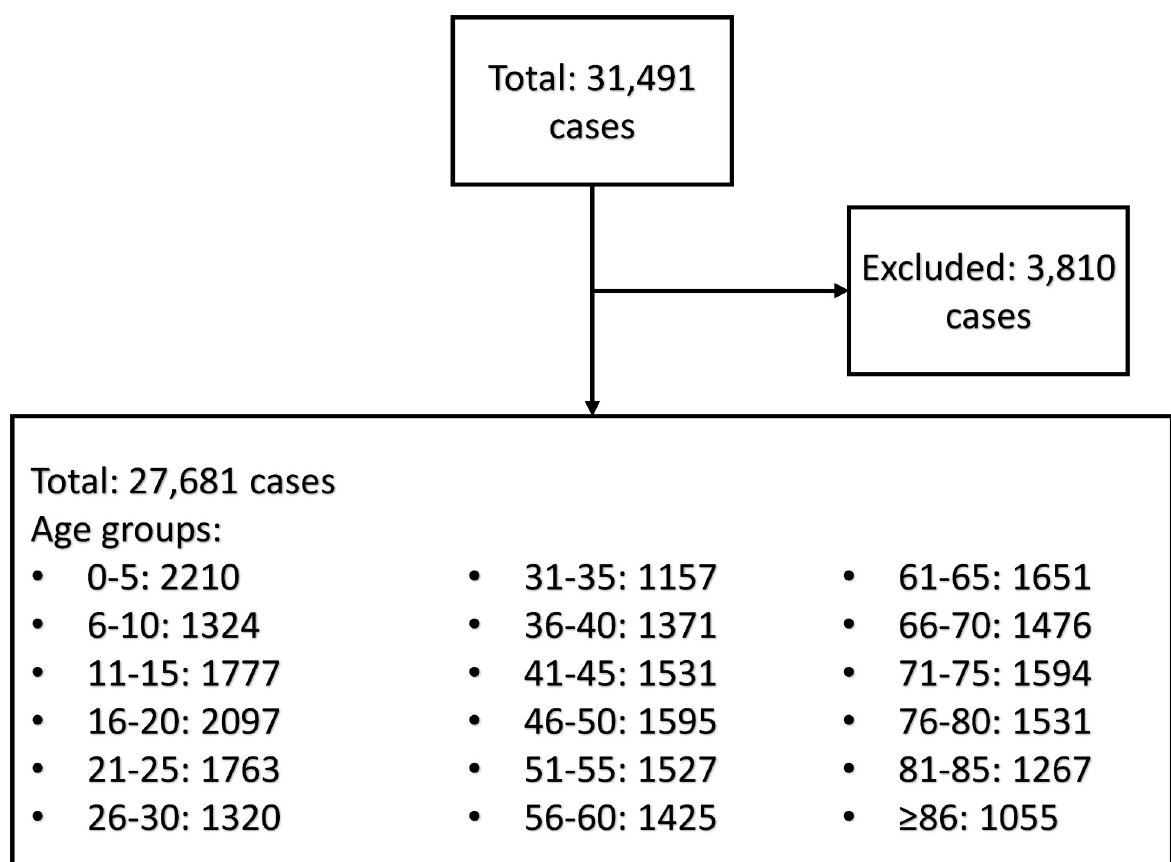
Fig 1. Distribution of the data set over the age groups. Excluded data include patients with a length of stay (LOS) of 0 seconds and patients coming in with bite or needle stick injuries.